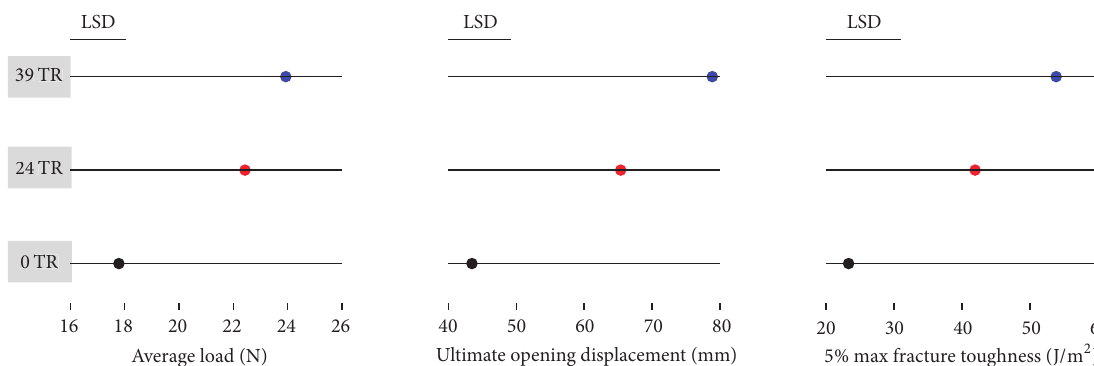
Figure 4: Effects of through-reinforcement (TR) (39 through-reinforcements versus 24 through-reinforcements versus 0 through- reinforcement) on some critical fracture characteristics of laminated birch wood specimens.